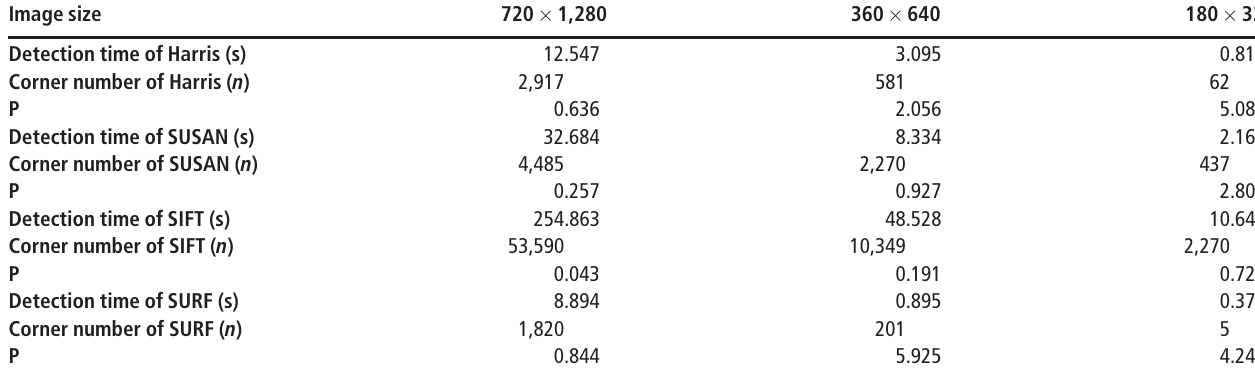
Table 1 Comparison of four kinds of algorithms Image size